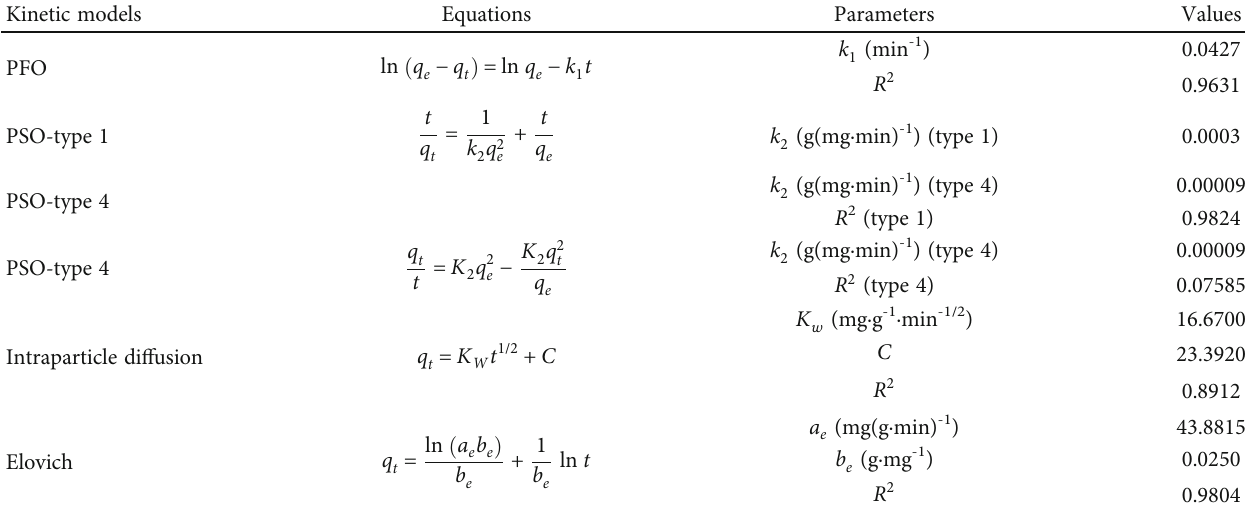
Table 1: The sorption kinetic models employed for this